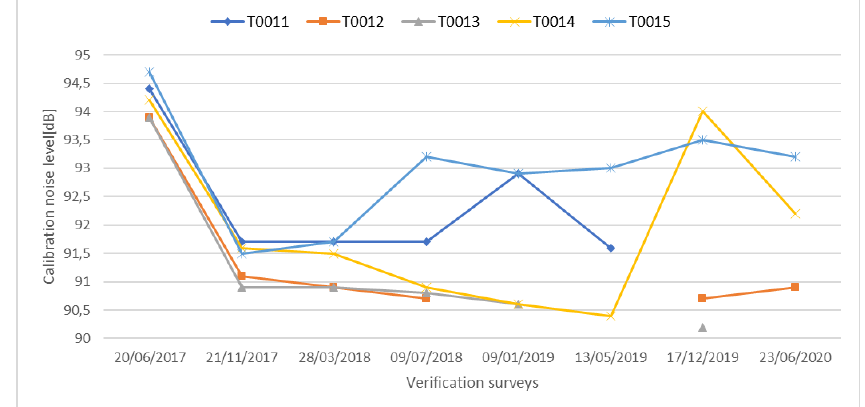
Figure 3: 1 kHz calibration check – MEMs sensors placed on streetlamps